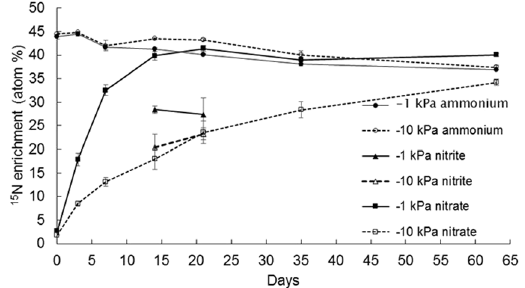
Figure 5. Inorganic-N 15 N enrichment over time. The 15 N enrichment of the ammonium-N (NH 4 + -N), nitrite-N (NO 2 − -N) and nitrate-N (NO 3 − -N) are shown over time following 15 N urea application at near saturated ( − 1 kPa) or field capacity ( − 10 kPa) soil moisture conditions. Symbols are means (n = 4) with vertical error bars the standard error of the mean.